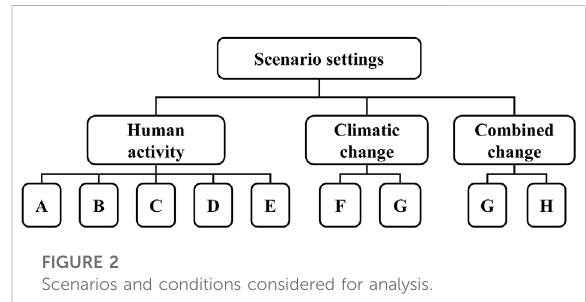
FIGURE 2 Scenarios and conditions considered for analysis.